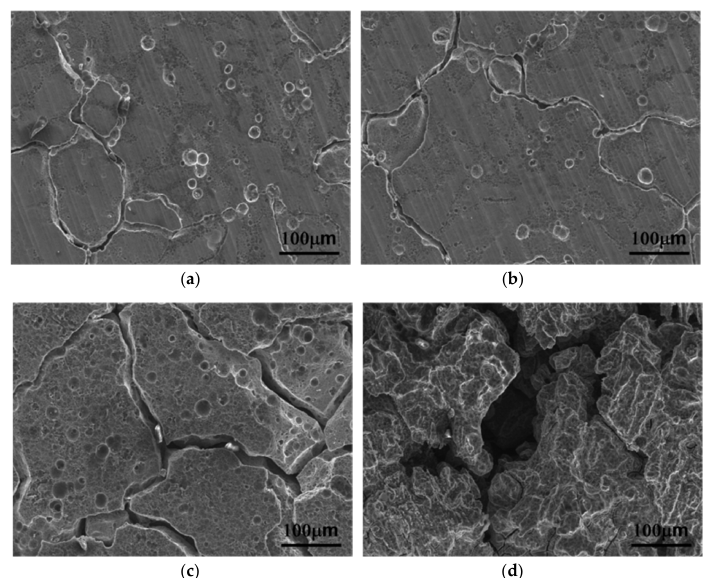
Figure 10. Scanning electron image of corroded surface of ( a ) alloy A , ( b ) alloy B , ( c ) alloy C and ( d ) alloy D after sensitization treatment.